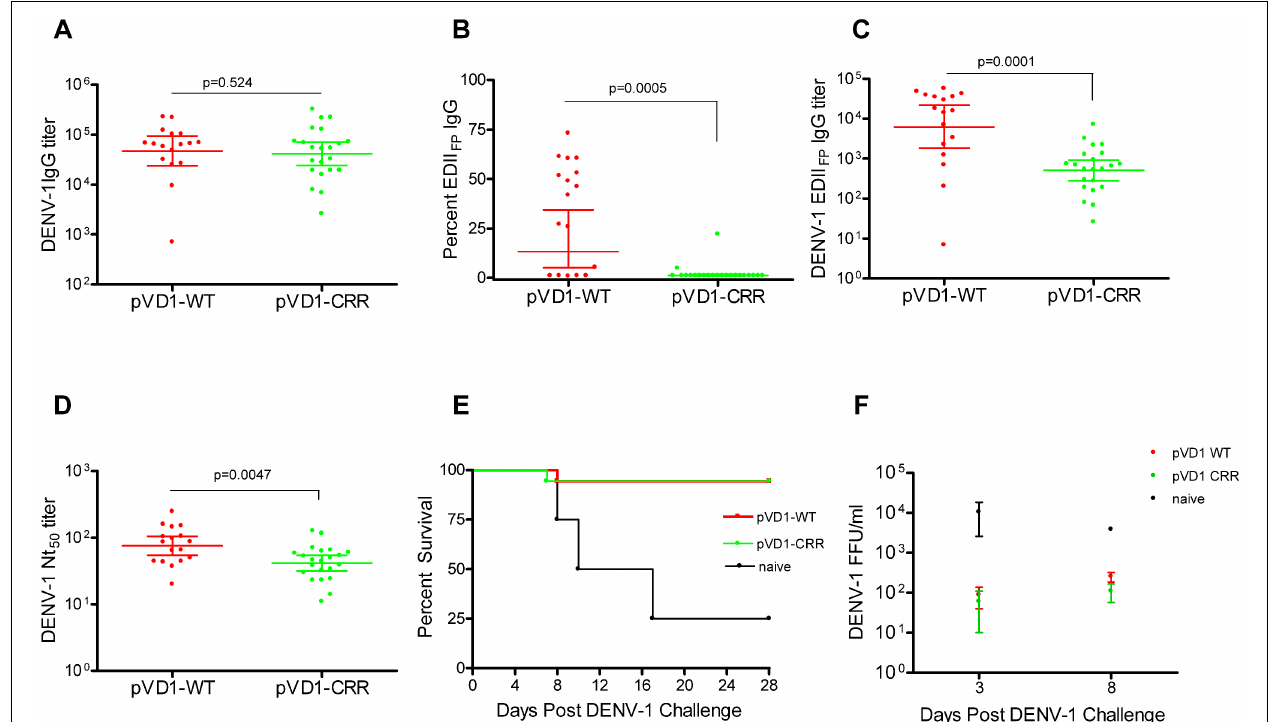
FIGURE 2 | Protective Efficacy: Both pVD1-WT and pVD1-CRR vaccines protectAG129 mice against lethal DENV-1 challenge. (A–D) 12 week post vaccination immunogenicity of AG129 mice immunized (i.m.) with 100 μ g of pVD1-WT or pVD1-CRR vaccines at 0, 4, and 8